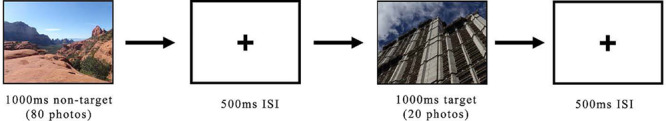
Images were shown for 1,000 ms followed by a 500 ms fixed-crossed inter-stimulus interval. In between blocks, a 45 s rest occurred.